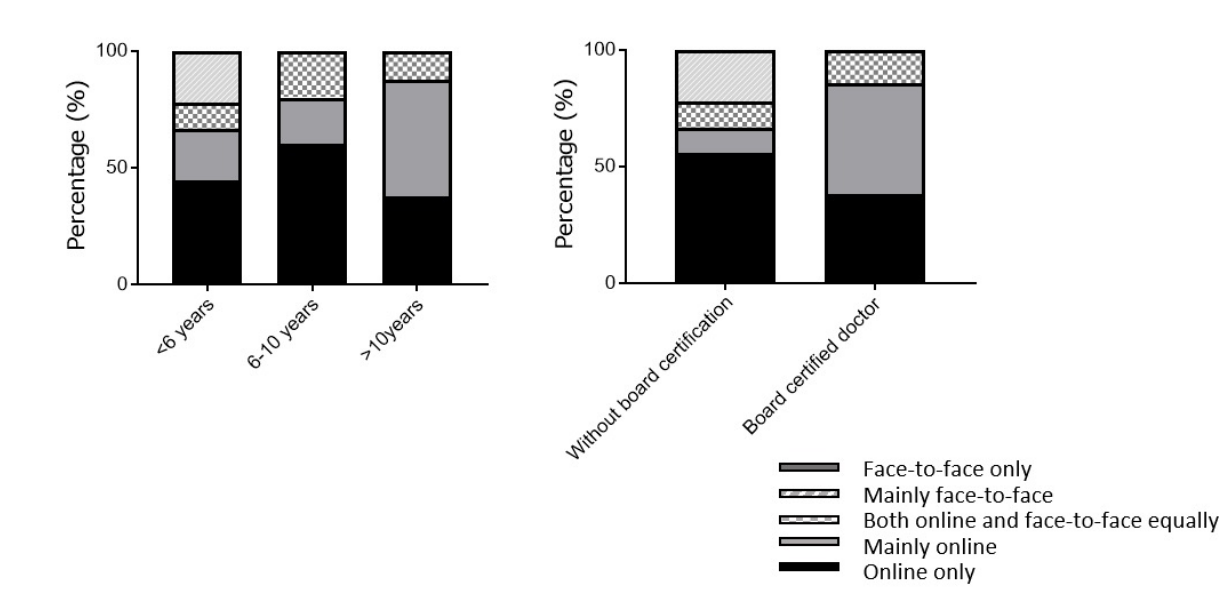
Supplemental Figure 3. Future forms of lectures. Almost all the participants, including those who wanted to use both online and face-to-face formats, wanted to continue holding online lectures in the